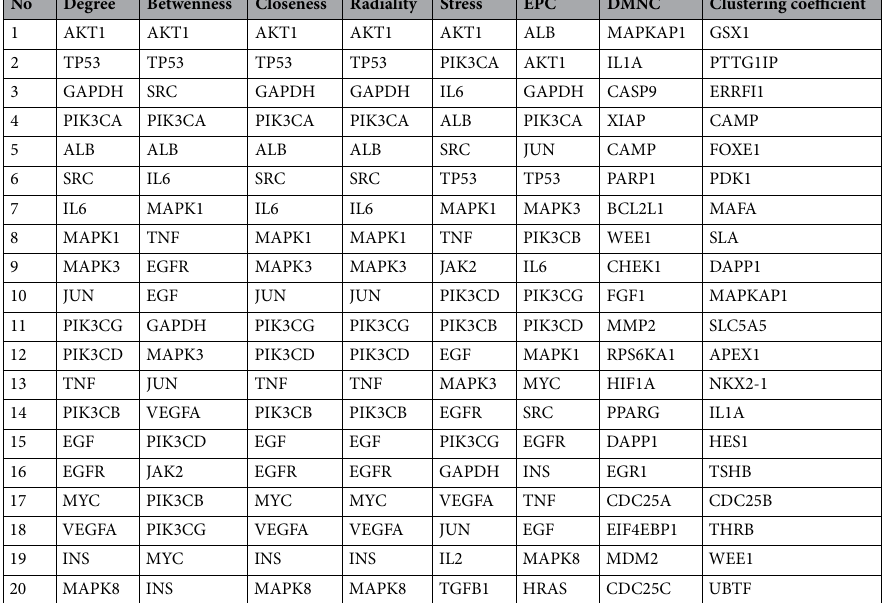
Table 1. Top-20 proteins of the eight informative centrality indices.